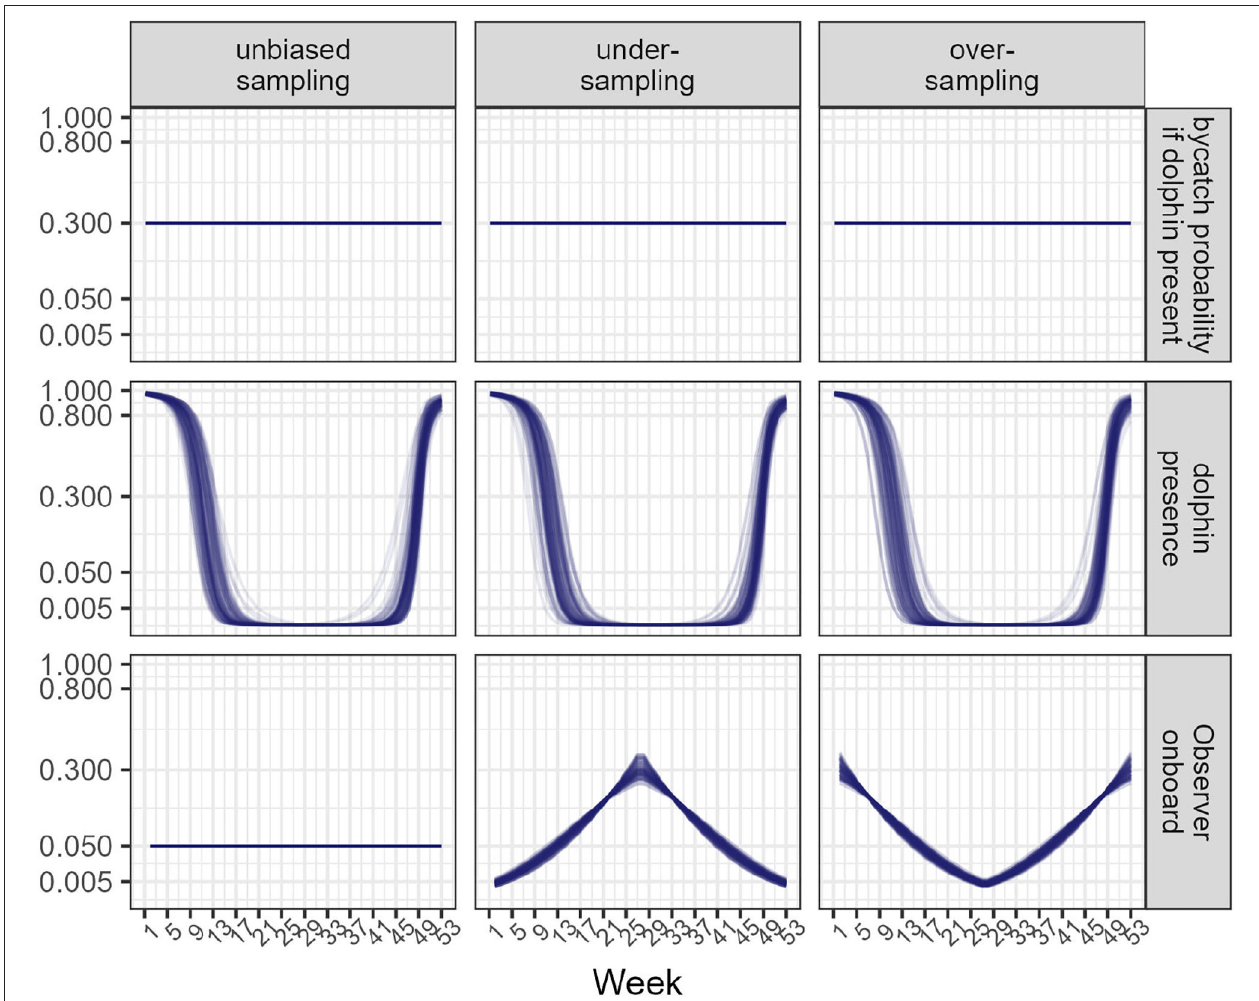
FIGURE 1 | Inputs for data simulation. Top: bycatch probability if dolphins are present during a fishing operation. Middle: dolphin presence during a year. Bottom: Probability for a skipper to accept an observer onboard. Left: sampling is unbiased; Middle column: sampling is biased downwards (under-sampling). Right: sampling is biased upwards (over-sampling). Each line corresponds to one of the 100 data simulations that were carried out. The y -axis is on a square-root scale to better visualize small